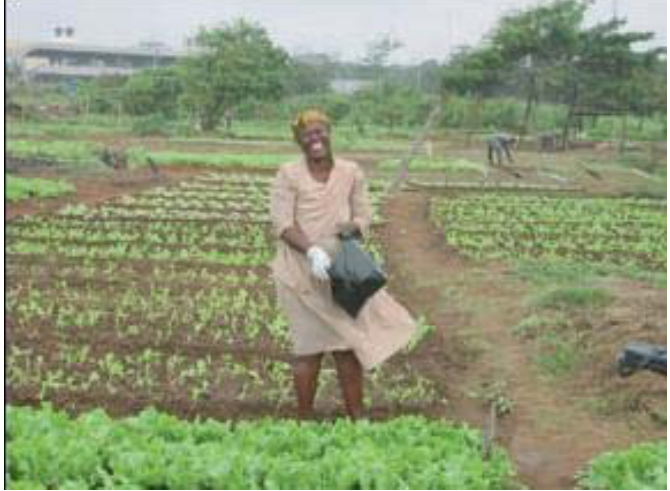
Figure 2. Urban farming in Accra, Ghana (source: